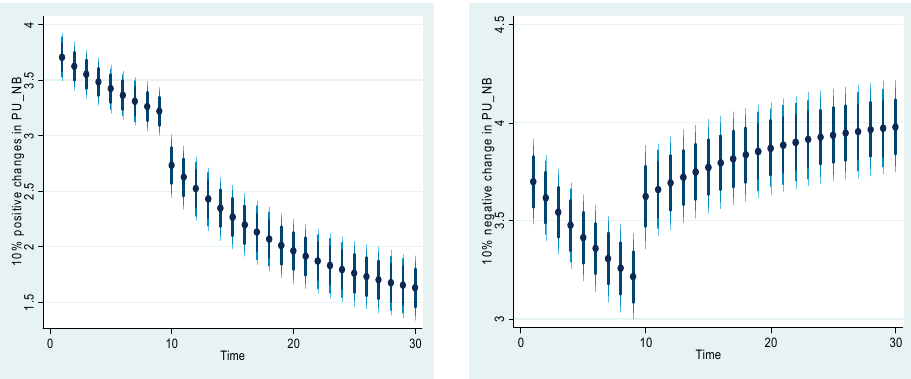
Figure 4. Graphical illustration of the response of stock prices (NYSE composite index) to a 10% increase (in the left portion of the Figure) and 10% decrease (in the right portion of the Figure) in PU_NB.